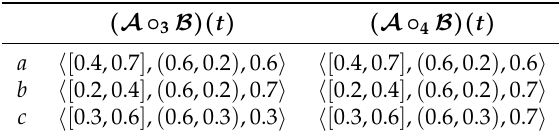
Table 3. ( A ◦ 3 B )( t ) and ( A ◦ 4 B )( t )